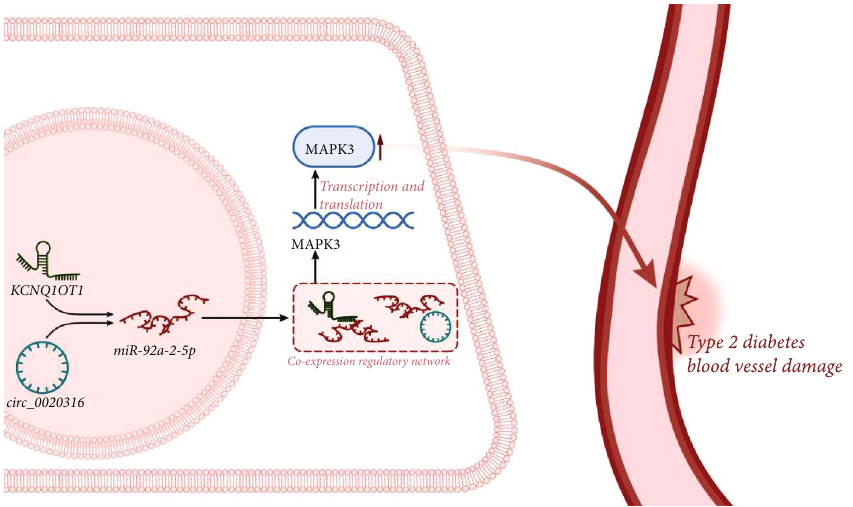
Figure 8: Mechanism of KCNQ1OT1/circ_0020316-miR-92a-2-5p-MAPK3 coexpression regulatory networks in vascular injury in T2DM. KCNQ1OT1/circ_0020316-miR-92a-2-5p-MAPK3 coexpression regulatory networks may contribute to the development of vascular injury in T2DM by elevating MAPK3